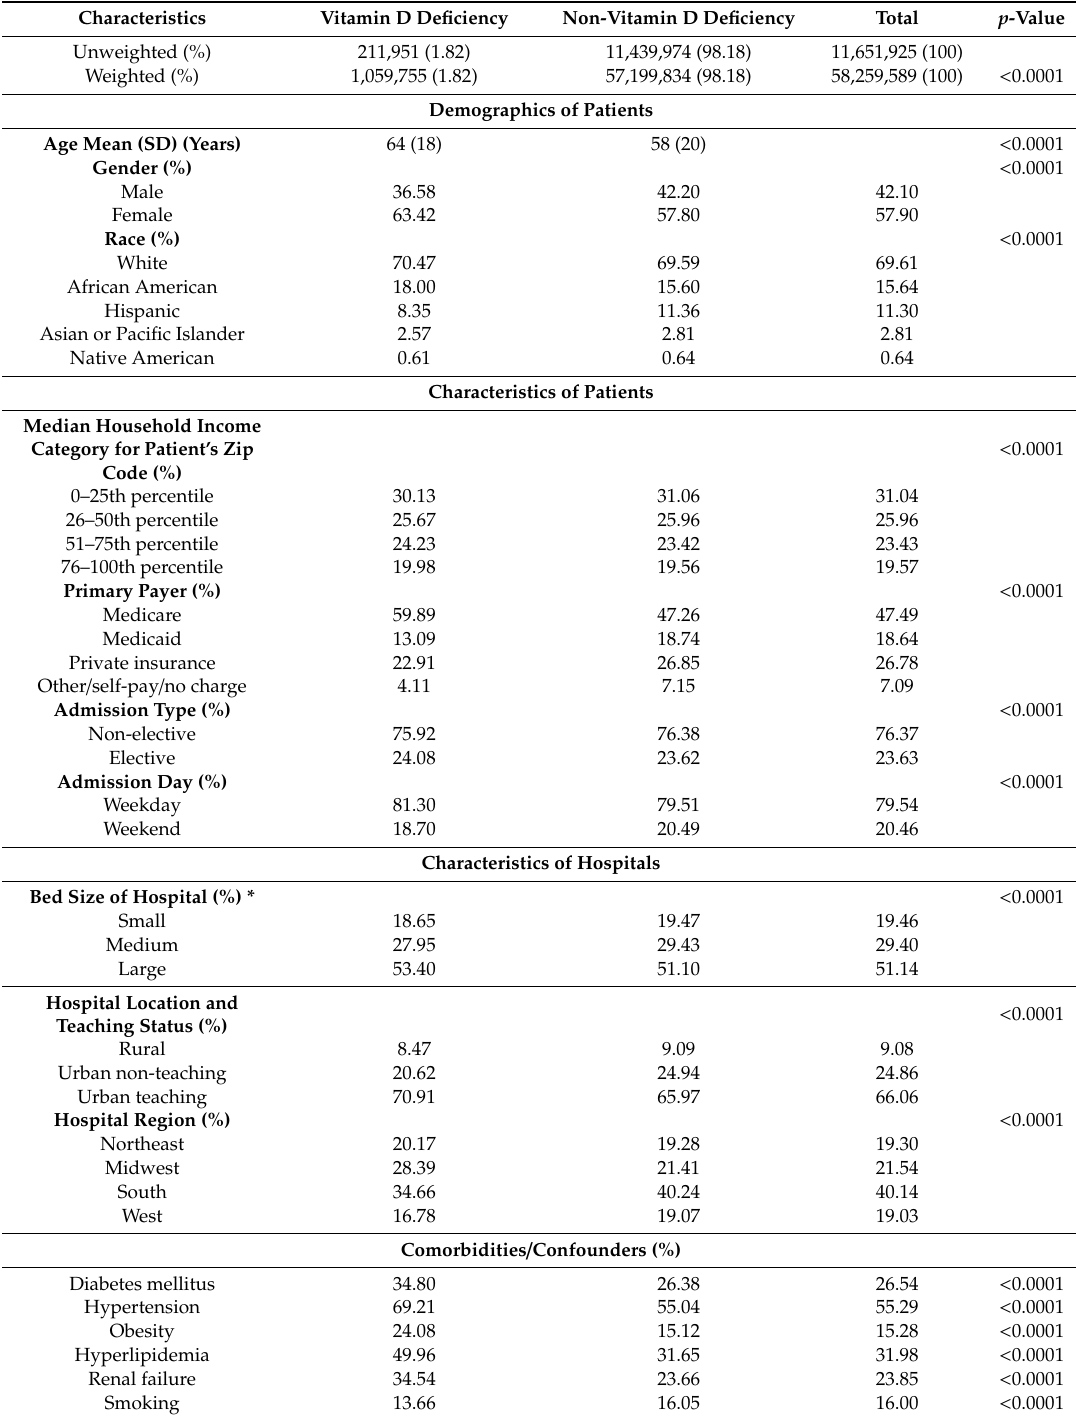
Table 1. Characteristics of USA hospitalizations identified with vitamin D